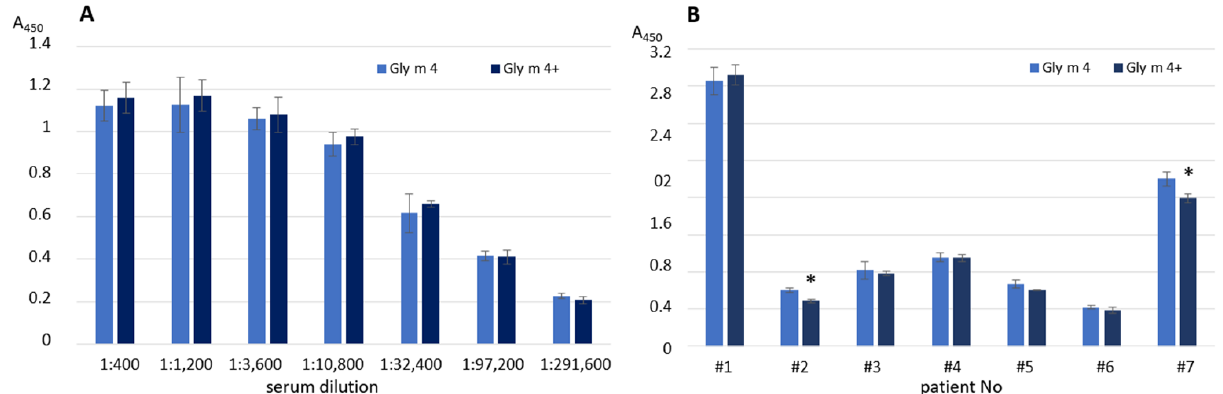
Figure 3. Effects of Gly m 4 heating on the binding of polyclonal rat anti-Gly m 4 IgG ( A ) or human IgE from sera of allergic patients ( B ). Gly m 4, Gly m 4+—the intact and preheated allergen, respectively. Error bars represent standard deviation between technical replications. Differences in mean A values between intact and preheated Gly m 4 for each patient were compared by t -test (significance levels is * p < 0.05).